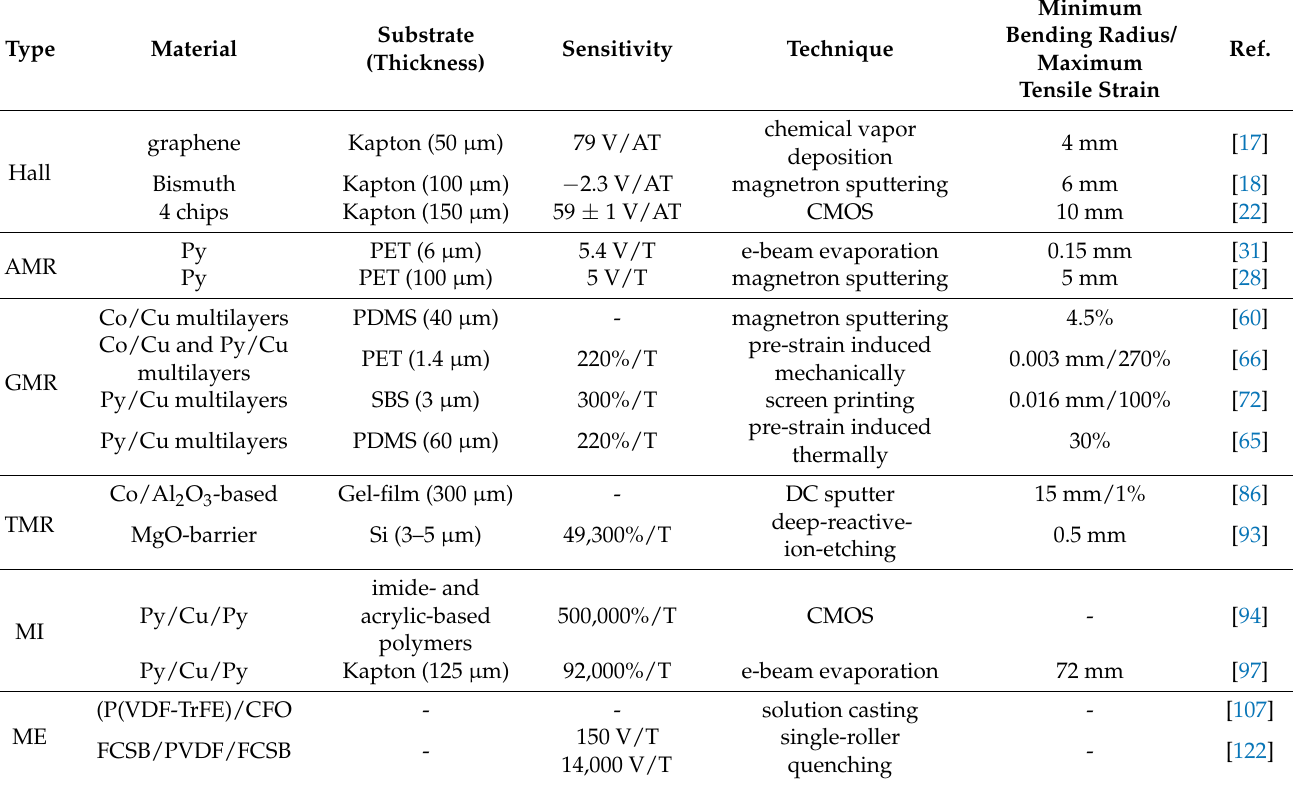
Table 1. Comparison of technologies for flexible magnetic sensors. The table summarizes some sensor’s features such as materials, substrate, thickness, sensitivity, technique, minimum bending radius, and maximum tensile